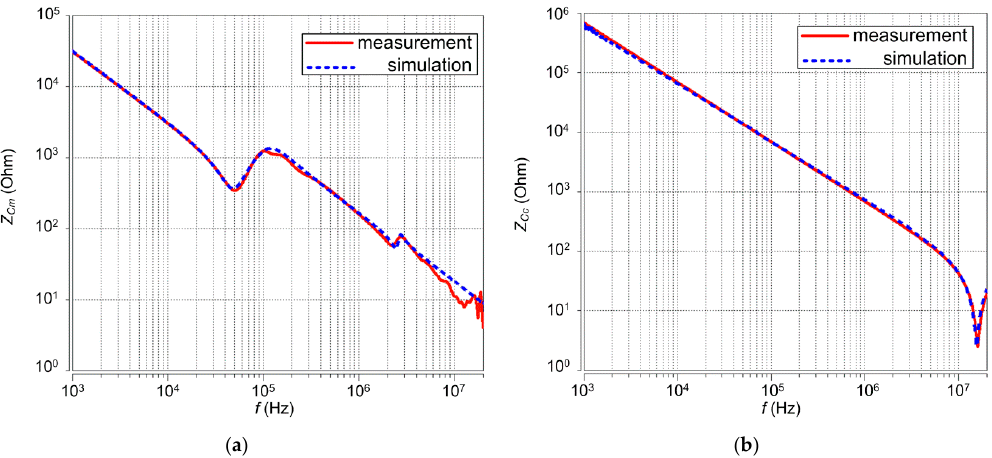
Figure 13. Measured and simulated frequency characteristics of the common-mode impedance: ( a ) induction machine; ( b ) cable.